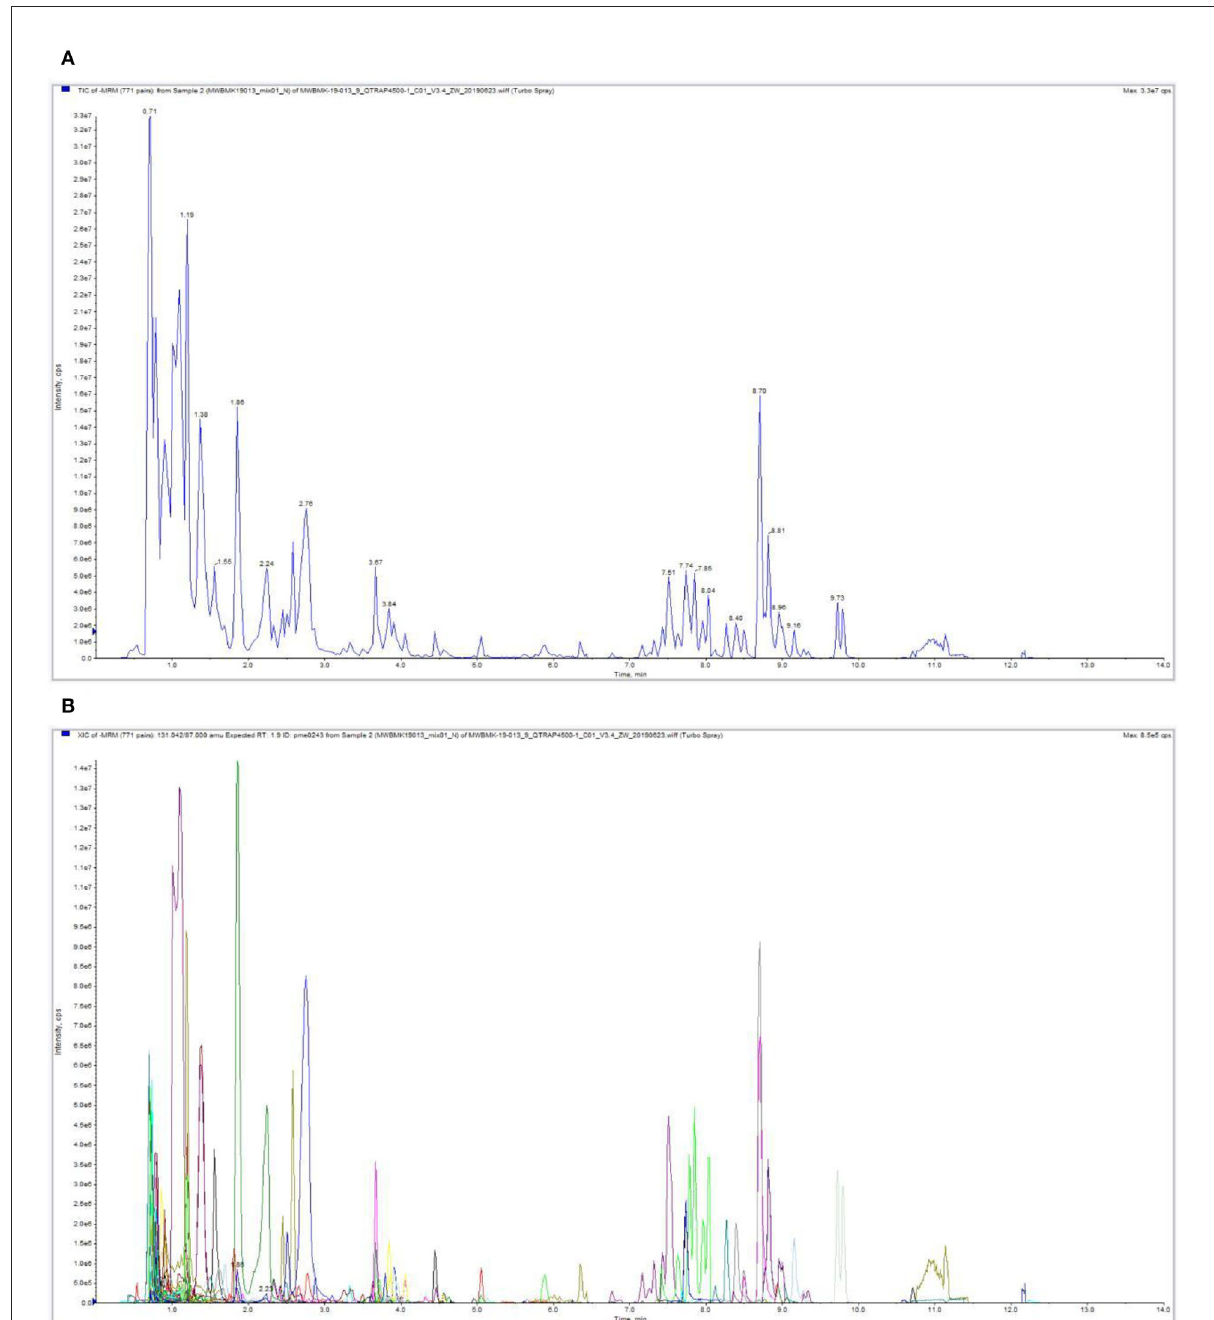
FIGURE3 The overlay analysis of the QC-TIC and multipeak detection in MRM analysis of the metabolome. (A) The ion current of one sample, as revealed by mass spectrometry detection. (B) A multipeak detection plot of the metabolites in the multiple reaction monitoring mode.